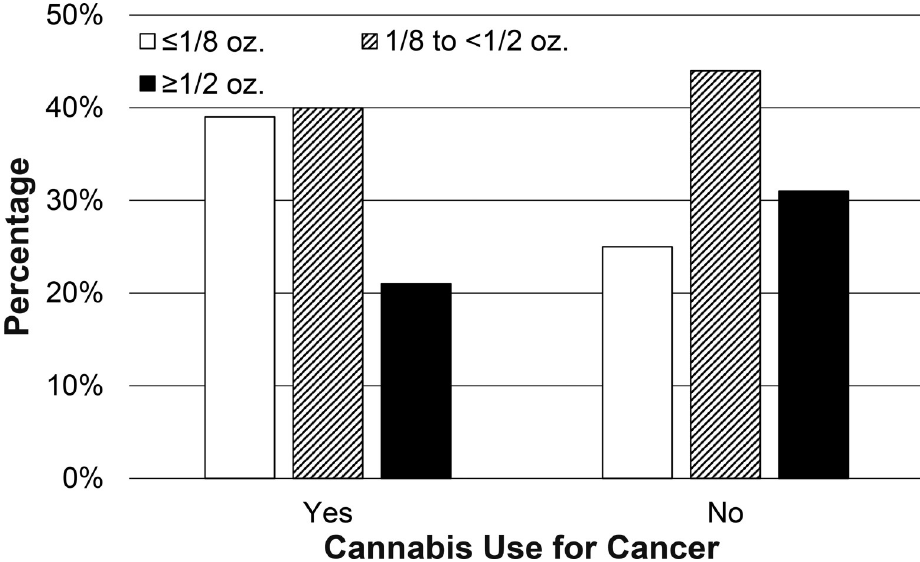
Fig 2. Quantities of Cannabis consumed. Amount of Cannabis consumed per week for those who did or did not endorse cancer diagnosis.